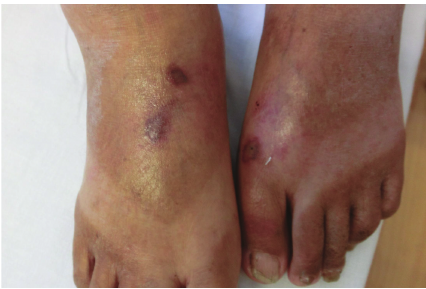
Figure 1: Clinical appearance of the stung sites at hospitalization. Central white necrosis and surrounding erythema were found on dorsum of feet. The patient was stung in fifteen